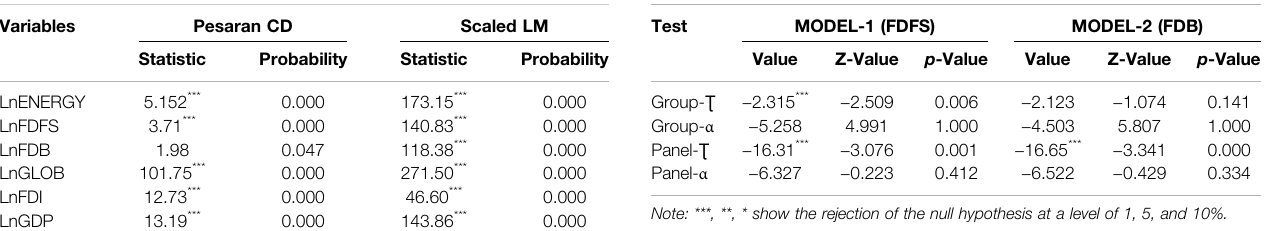
TABLE 2 | Test for cross-sectional dependence.